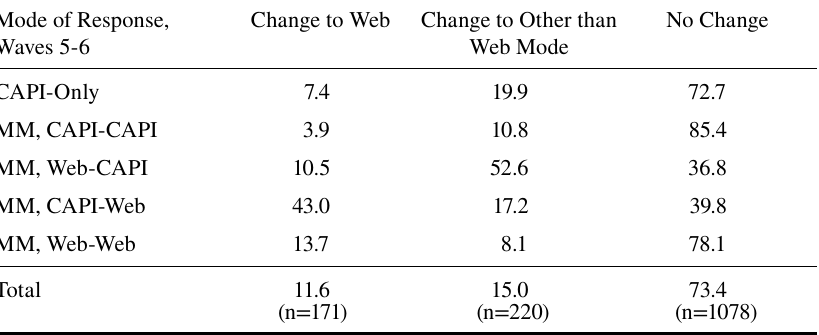
Percent Switching of Mode Preference by Mode of Response Across Waves 5 to 6